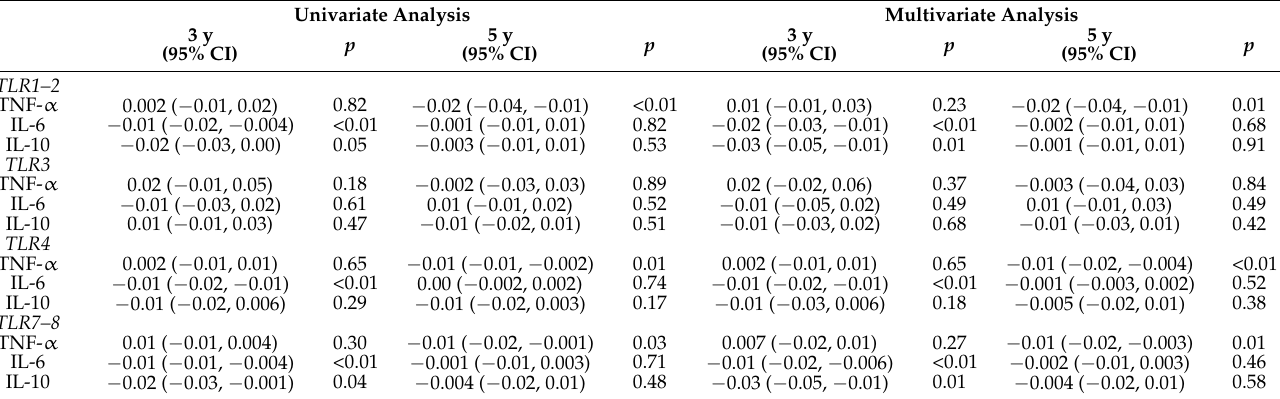
Table 3. Association between serum zinc concentration and TLR-stimulated cytokine responses in children at ages 3 and 5 years.